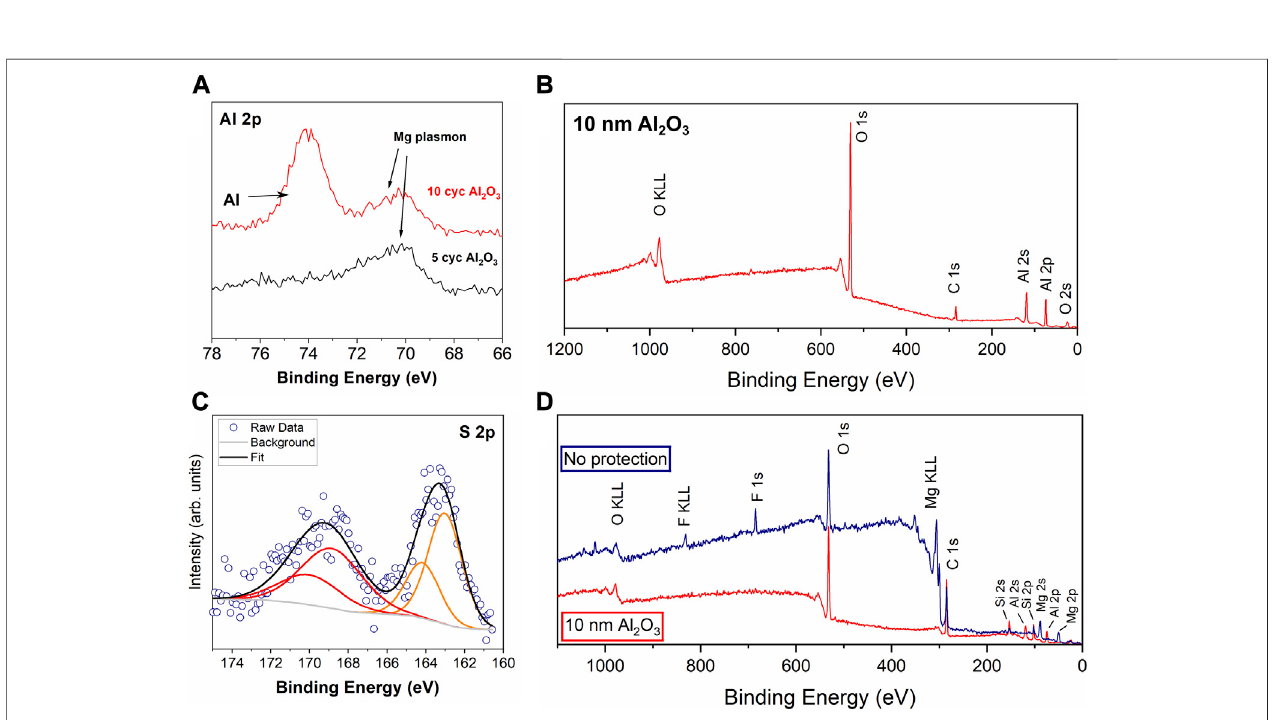
FIGURE3| XPSof (A) evaporatedMgafter5and10Al 2 O 3 ALDcyclesand (B) Mgmetalfoilafter100cyclesAl 2 O 3 ( ∼ 10 nm) (C) highresolutionS2pspectrumfrom XPS of the soaked Mg foil sample in (D) , where (D) shows XPS survey spectra of Mg metal electrodes soaked in 0.25 M Mg (TFSI) 2 in DME electrolyte for 24 h.